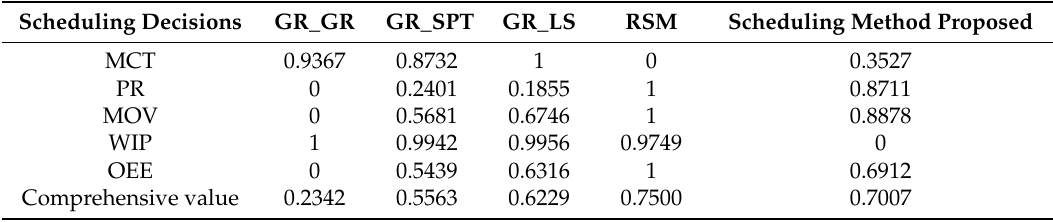
Table 3. Normalized value and comprehensive value of the five performance indicators under different scheduling